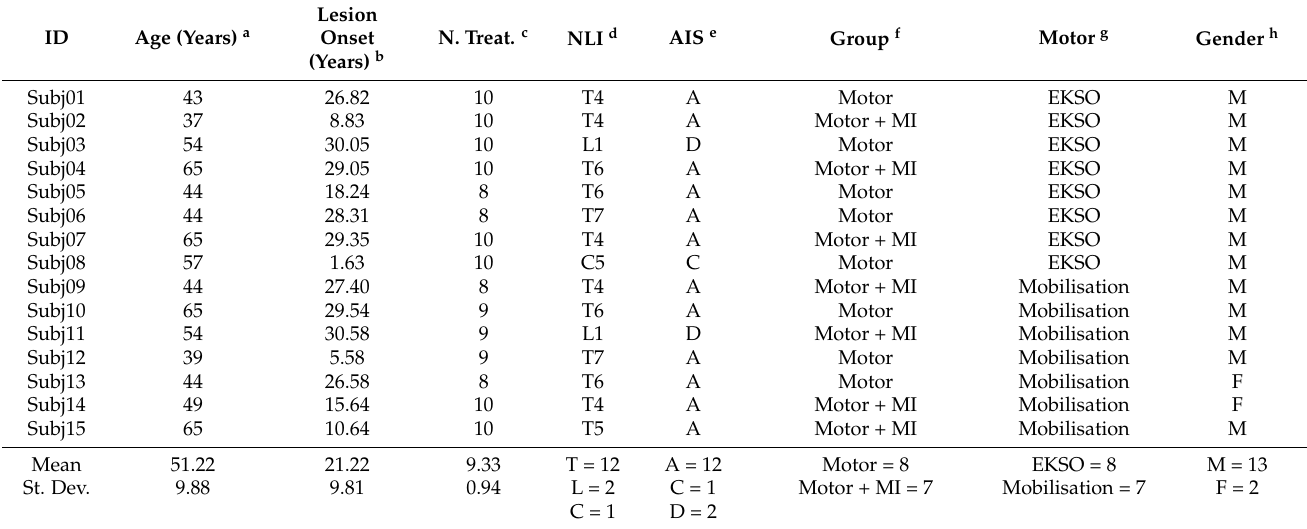
Table 1. Clinical and demographic data of the participants in the study.